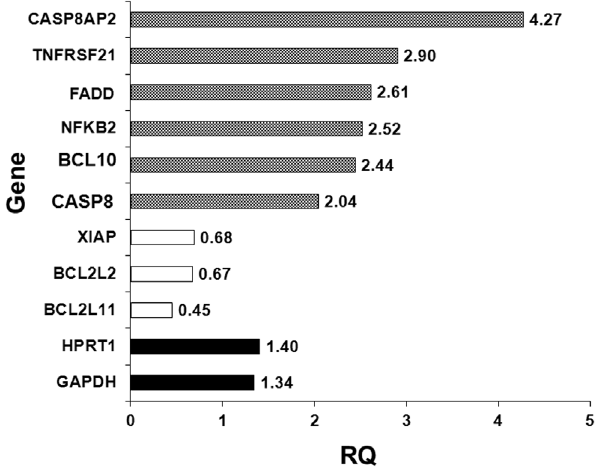
Figure 6. The effect of BP-C1 on gene expression. MCF-7 cells were treated with 750 m g/ml for 48 h. After treatment, total RNA was isolated and reverse transcribed.Gene expression of pro-apoptotic genes was detected using the Applied Biosystems H TaqMan H Array Plates. HPRT1 and GAPDH genes were used as housekeeping genes for internal control to correct the potential variation in RNA loading.